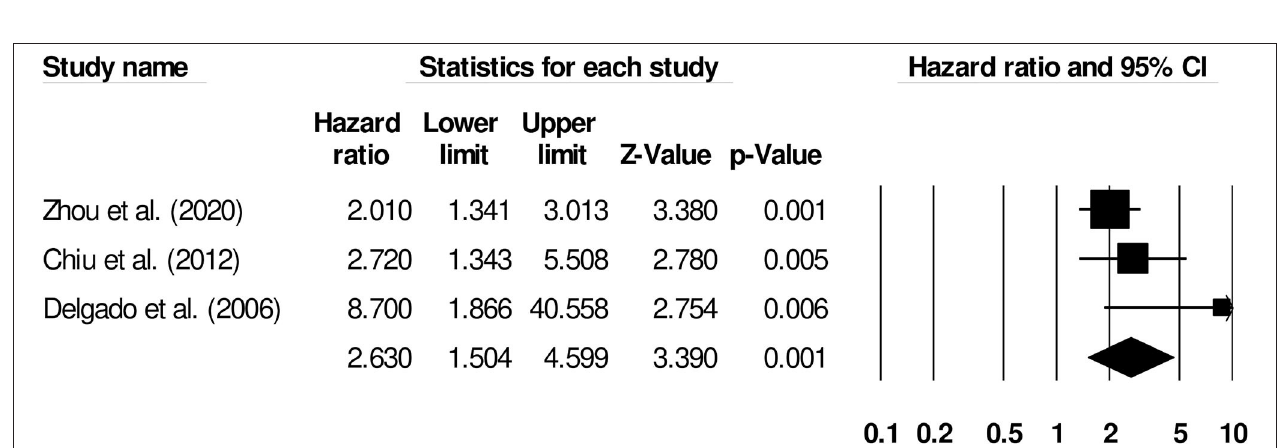
FIGURE 10 | Forest plot for studies evaluating the impact of D-dimer level on post-cryptogenic ischemic stroke mortality outcomes. Hazard ratios are presented as black boxes while 95% confidence intervals are presented as whiskers. A small hazard ratio represents a lower influence of D-dimer levels on stroke patient functional outcome while a higher hazard ratio represents a higher influence.